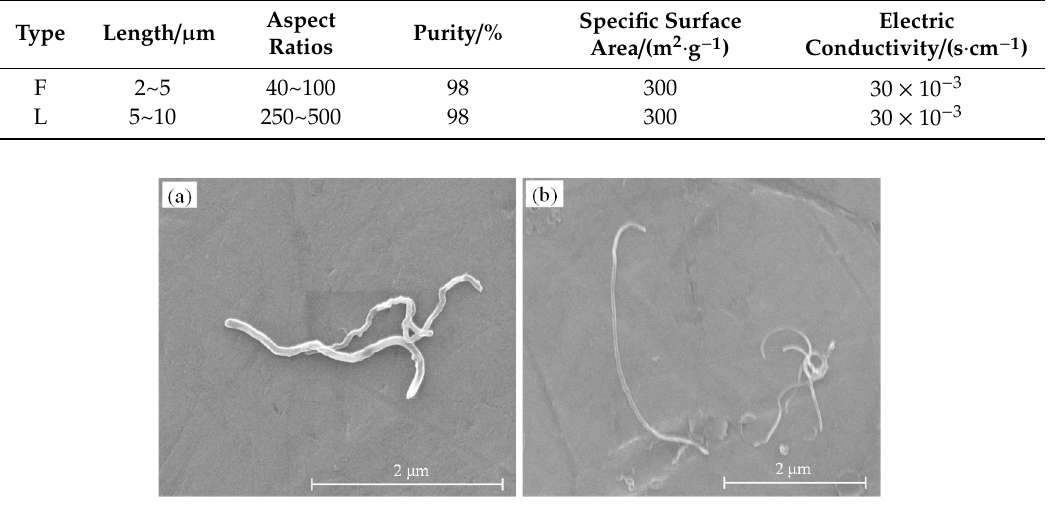
Table 1. Chemical properties of ordinary Portland cement.